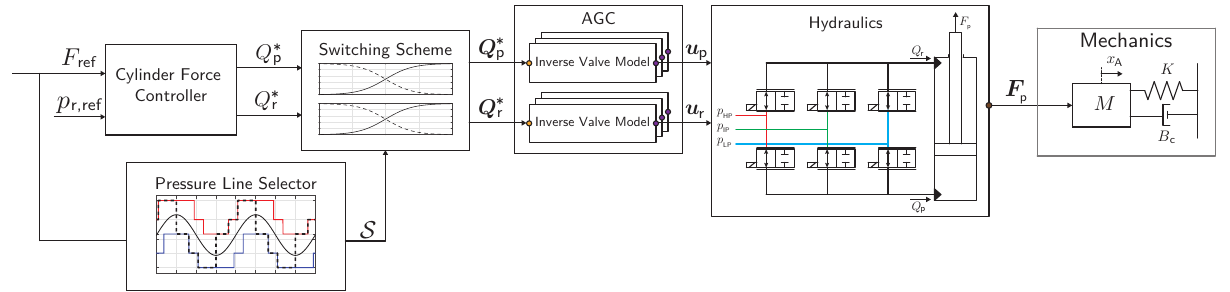
Figure 12: Structure of the complete hydraulic control system of the MPL concept.